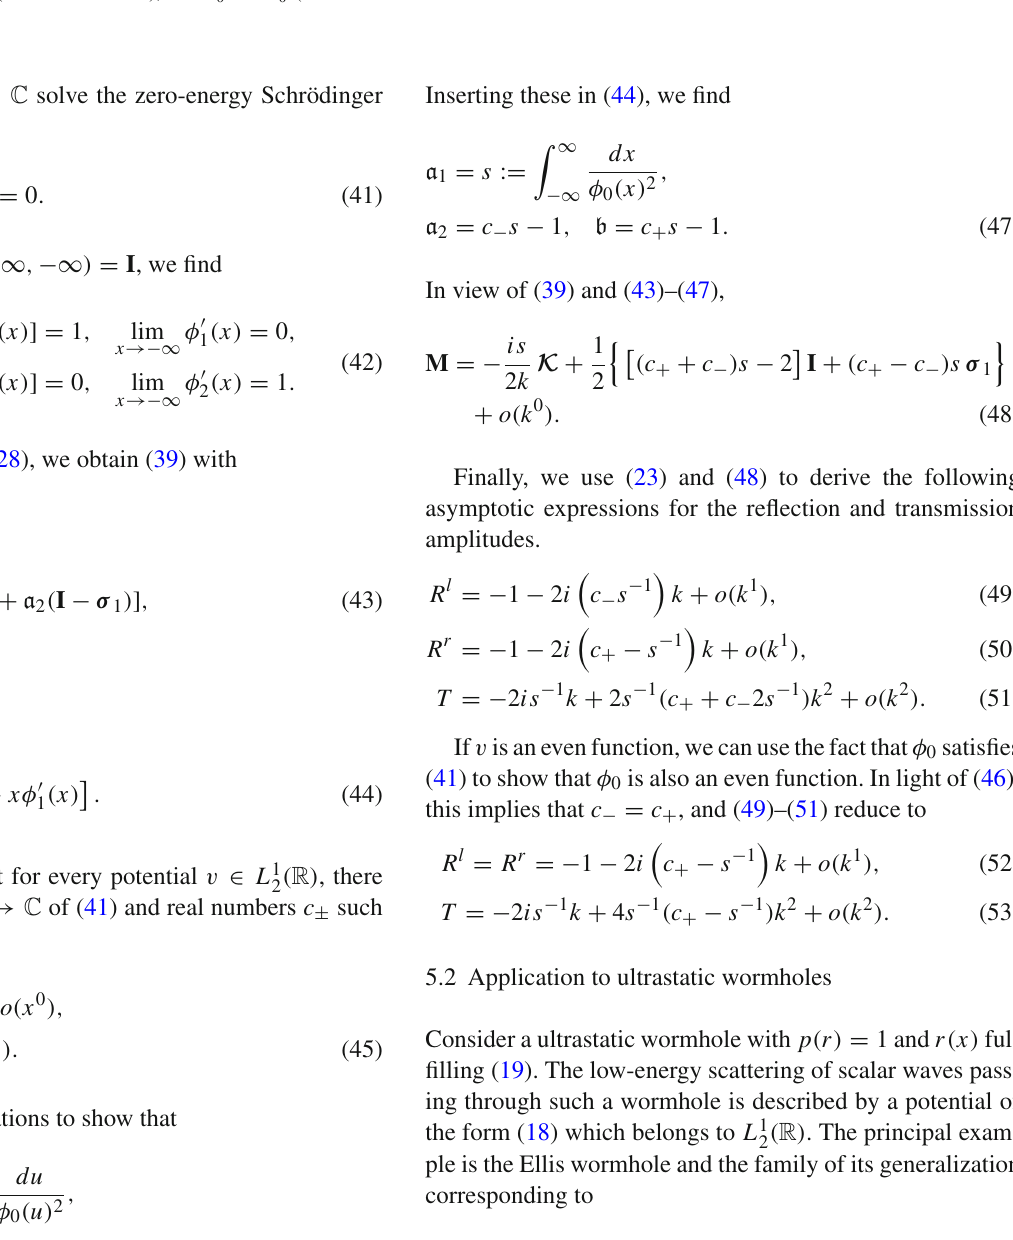
Fig. 3 Graphs of the transmission coefficient | T | 2 as a function of kr 0 for a sharp-transition wormhole with l = 0 and x 0 = r 0 (thick solid blue curve), x 0 = r 0 / 2 (dashed red curve), and x 0 = 2 r 0 (thin solid